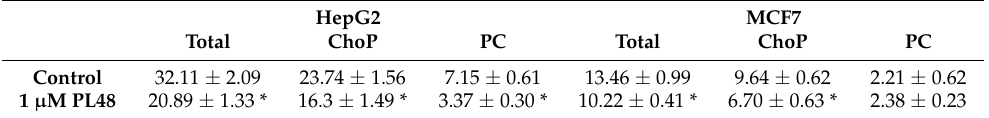
Table 1. Effect of PL48 on [methyl- 14 C]choline incorporation in HepG2 and MCF7. Cells were treated with 1 µ M PL48 for 48 h. Then, they were incubated with [methyl- 14 C]choline as described in the methods section. The total incorporation of choline and the incorporation of choline into ChoP and PC are expressed as nmol of choline incorporated per mg of cell protein and represent the mean ± SEM of two independent experiments conducted in triplicate. * p < 0.05. HepG2 MCF7 Total ChoP